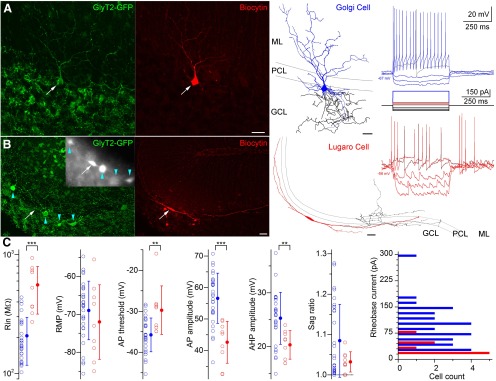
Morphological and electrophysiological characterization of granule cell layer interneurons in the GlyT2-GFP mouse. A, Maximum intensity projection image of a confocal image Z-stack of an in vitro recorded and biocytin (red)-labeled GoC showing GlyT2-GFP immunoreactivity (green). Scale bar, 20 μm. The Neurolucida reconstruction of this cell is shown on the right (dendrites in blue; axon in black). Scale bar, 20 μm. Voltage responses of this cell to DC current injections are shown on the far right. B, As in A, but showing a Lugaro cell. Although the GFP signal was not detectable in this cell after the recording, prior to patching this cell was clearly GFP positive, as shown in the epifluorescent grayscale image in the inset (arrow; arrowheads indicate adjacent GlyT2-GFP-expressing neurons). The Neurolucida reconstruction of this cell is shown on the right (dendrites in red; axon in black). Scale bar, 20 μm. Voltage responses of this cell to DC current injections are shown on the far right. Note the frequent occurrence of spontaneous IPSPs in the traces. The IPSPs are depolarizing due to the elevated Cl− concentration of the intracellular solution. C, Summary of some electrophysiological properties of morphologically identified Golgi (blue) and Lugaro (red) cells. Rin, Input resistance; Rheobase, minimum current required to generate at least one action potential. **p < 0.01, ***p < 0.001. Testing membrane potential (RMP) and Sag ratio were not different between cell types (p = 0.34 and p = 0.46, respectively). Average rheobase current was significantly different between cell types (p = 0.0002). Comparisons were made by Mann–Whitney U test or one-way ANOVA.